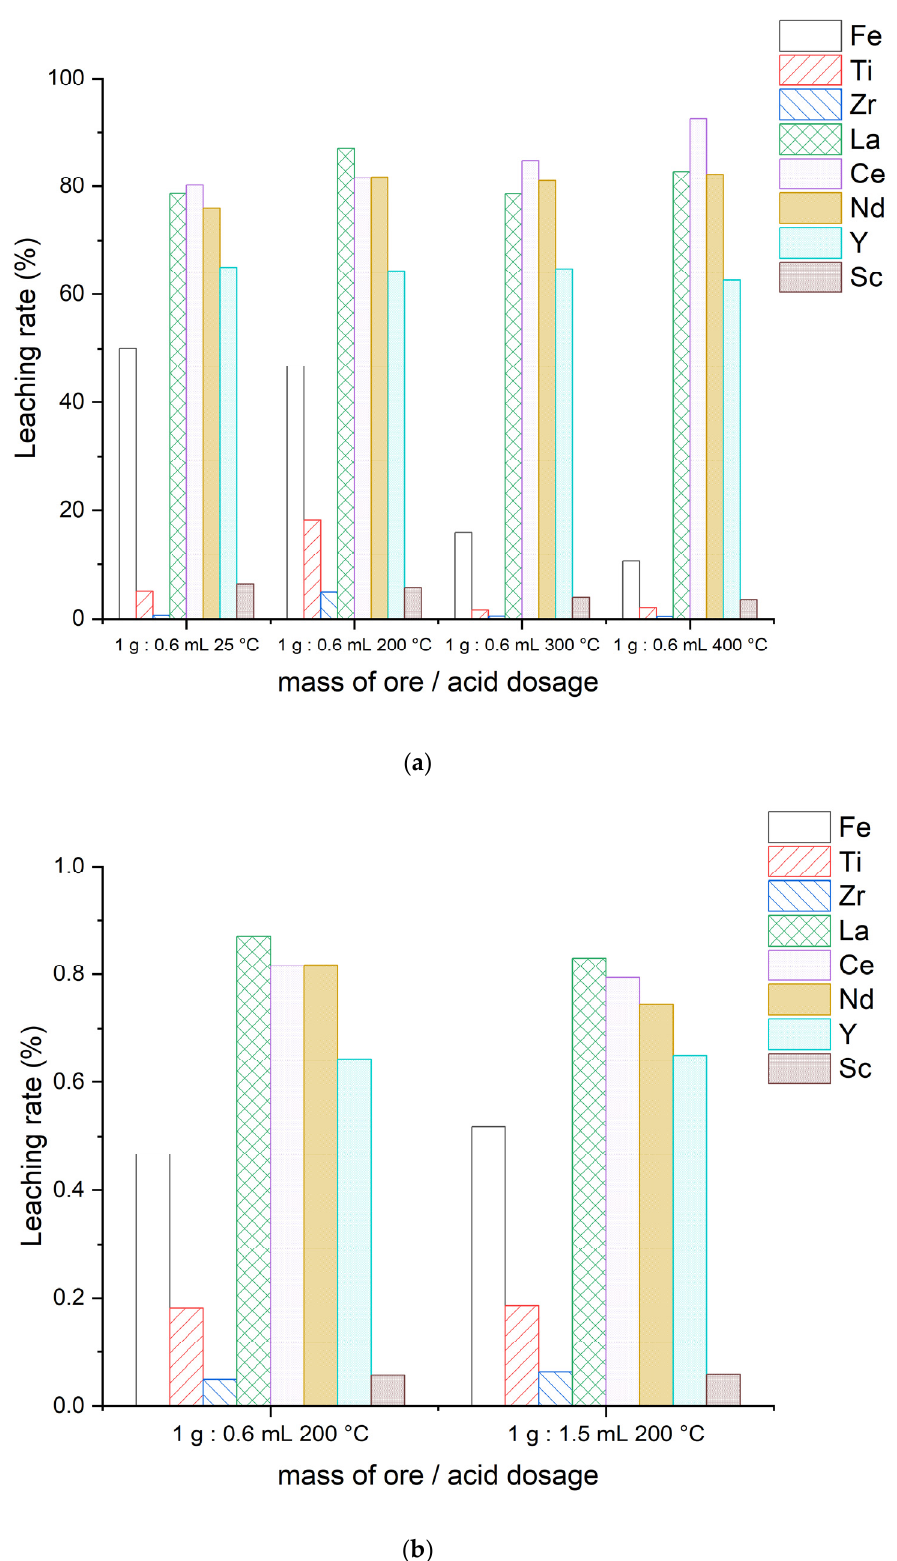
Figure 12 . Leaching rate of iron, zirconium, lanthanum, cerium, neodymium, yttrium, and Figure 12. Leaching rate of iron, zirconium, lanthanum, cerium, neodymium, yttrium, and scandium, scandium, ( a ) varying the temperature and ( b ) varying the acid dosage at 200 °C. Experi- ( a ) varying the temperature and ( b ) varying the acid dosage at 200 ◦ C. Experimental conditions for mental conditions for baking: 1 g of ore; 2 h. Experimental conditions for water leaching: baking: 1 g of ore; 2 h. Experimental conditions for water leaching: solid-liquid ratio = 1/10; t = 2 h; solid-liquid ratio = 1/10; t = 2 h; under magnetic stirring. under magnetic